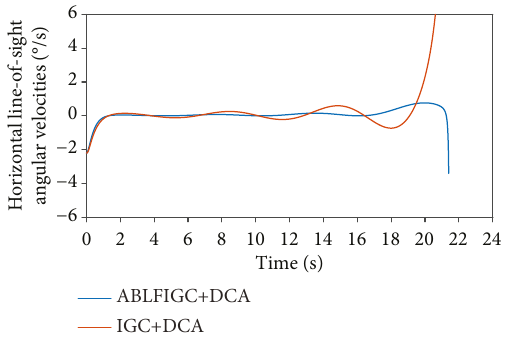
Figure 9: Curves of angular velocities of the horizontal line of sight of the interceptor missile in Scenario 2: ABLFIGC+DCA refers to a combination of the proposed asymmetric barrier Lyapunov function-based IGC algorithm and the dynamic control allocation algorithm; IGC+DCA refers to a combination of the IGC algorithm subject to the traditional dynamic surface sliding-mode control law and the dynamic control allocation algorithm.